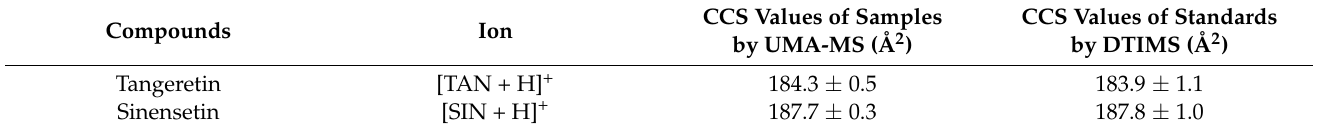
CCS Values of Samples CCS Values of Standards by UMA-MS (Å 2 ) by DTIMS (Å 2 )